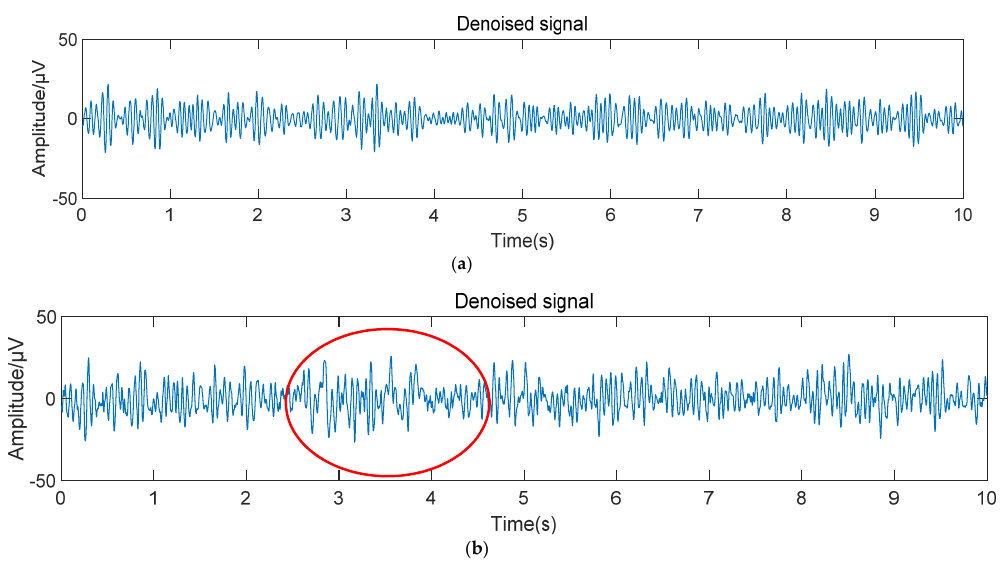
Figure 4. EEG signals after artifact removal by different methods. ( a ) The reconstructed signal after artifact removal by this method. ( b ) The reconstructed signal after artifact removal by EEMD-SOBI method.